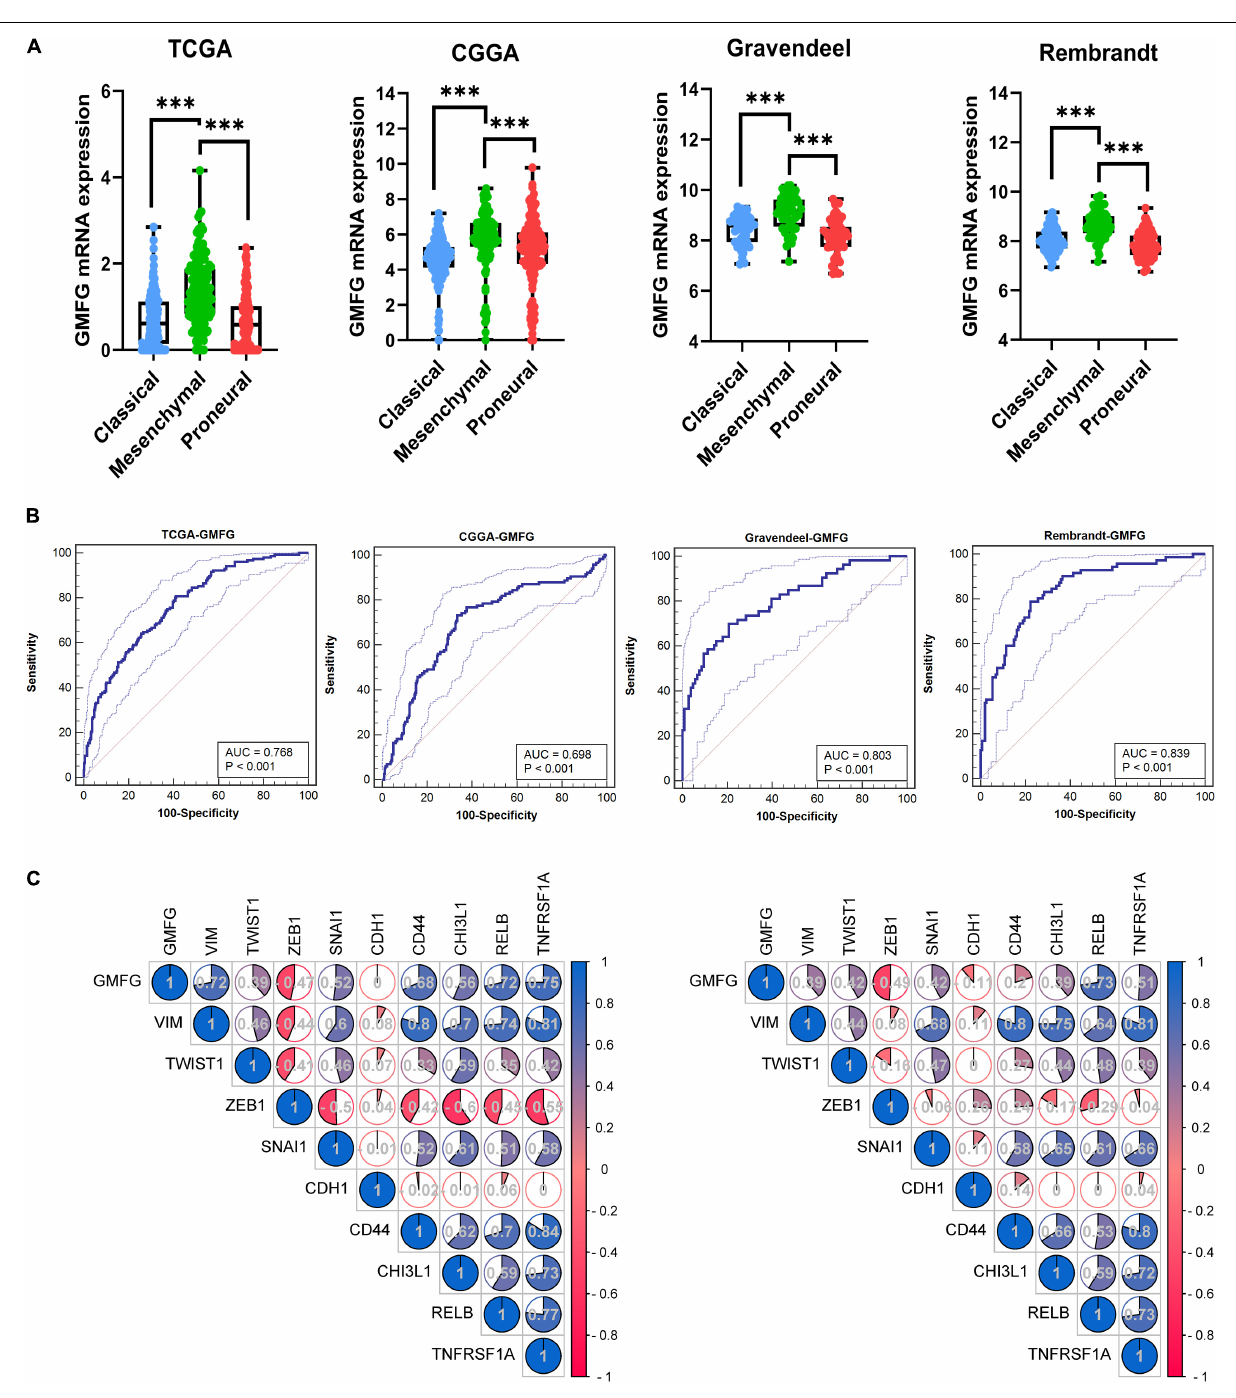
Frontiers in Molecular Neuroscience |